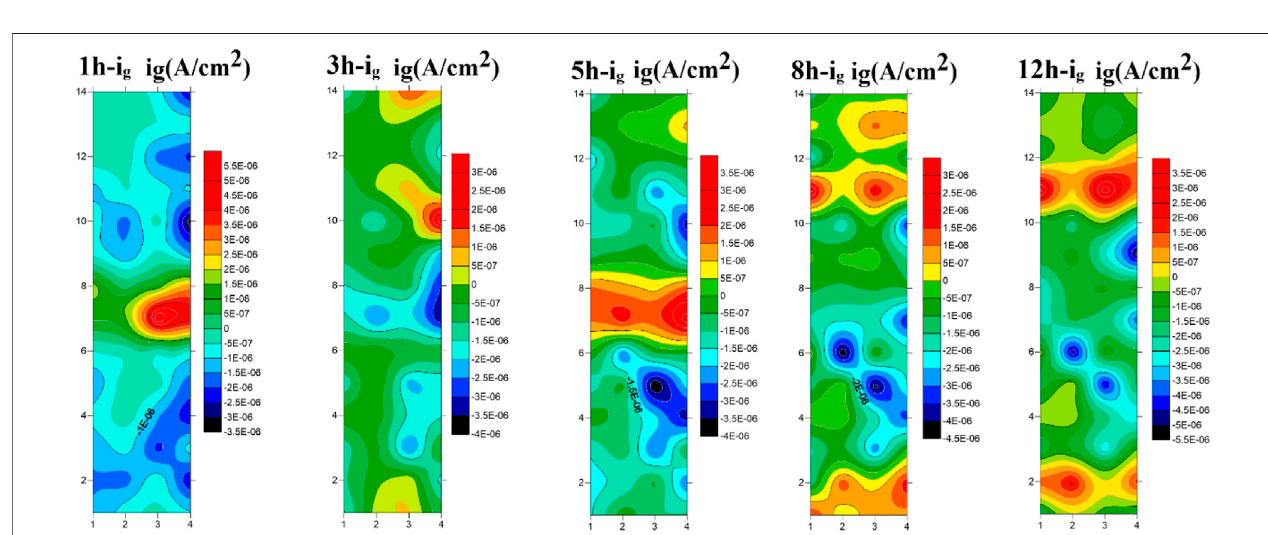
FIGURE 15 | WBE test results at 6 m/s fl ushing for 12 h after zonal coupling of welded joints.